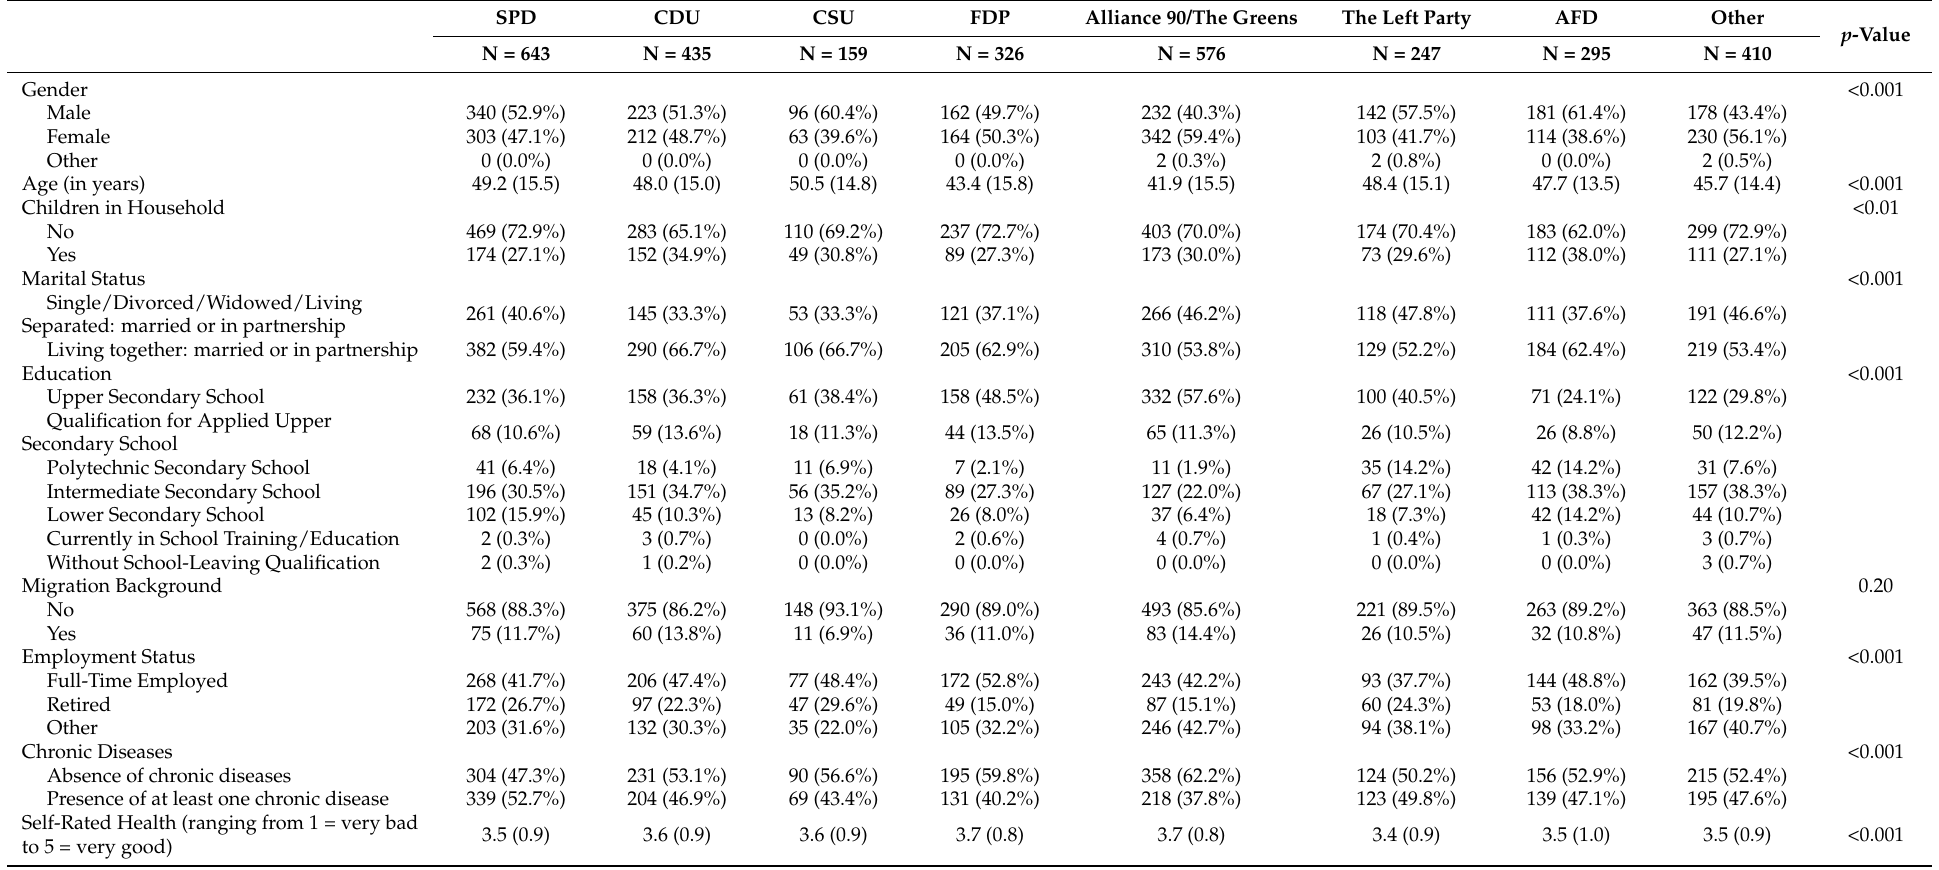
Table 1. Sample characteristics stratified by political party